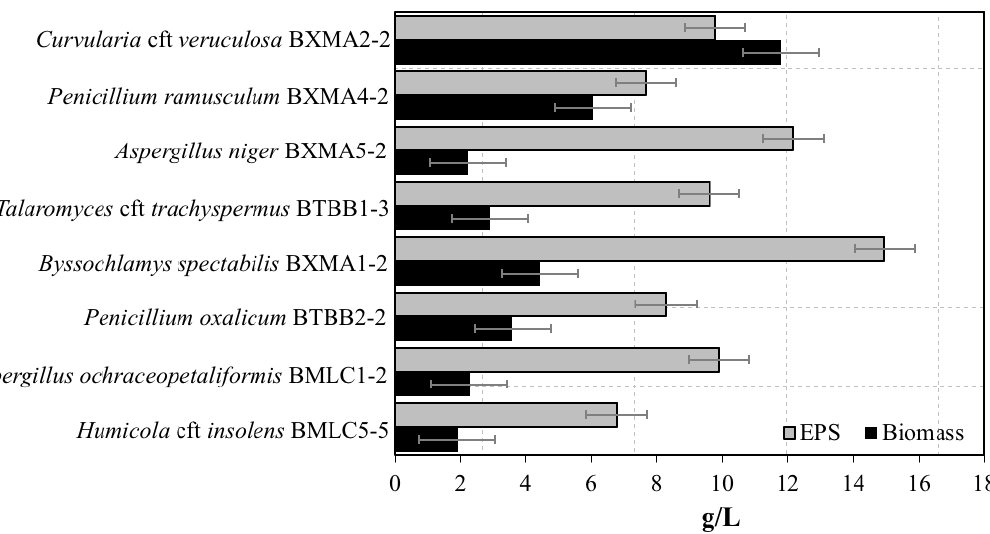
Figure 3. Exopolysaccharide (EPS) production by eight selected fungal isolates causing deterioration on a glass model.